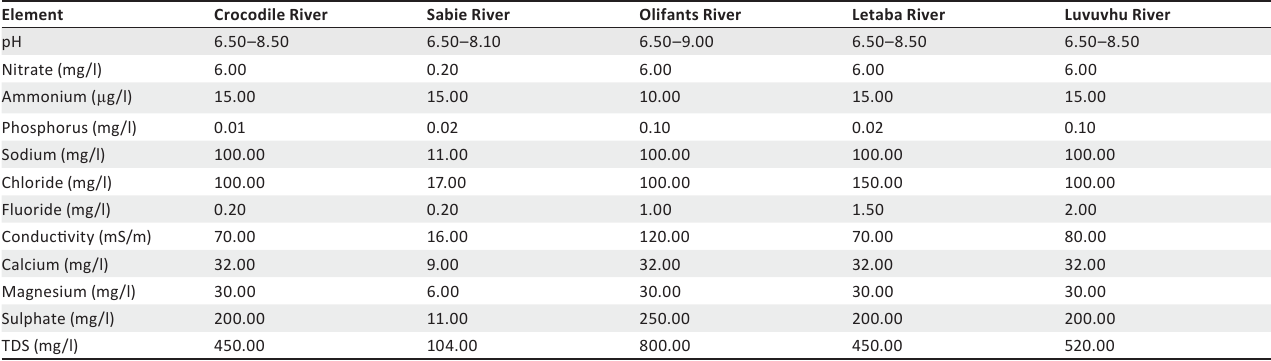
TABLE 3: Guidelines used to assess thresholds of potential concern for water quality, associated with the major Kruger National Park rivers.